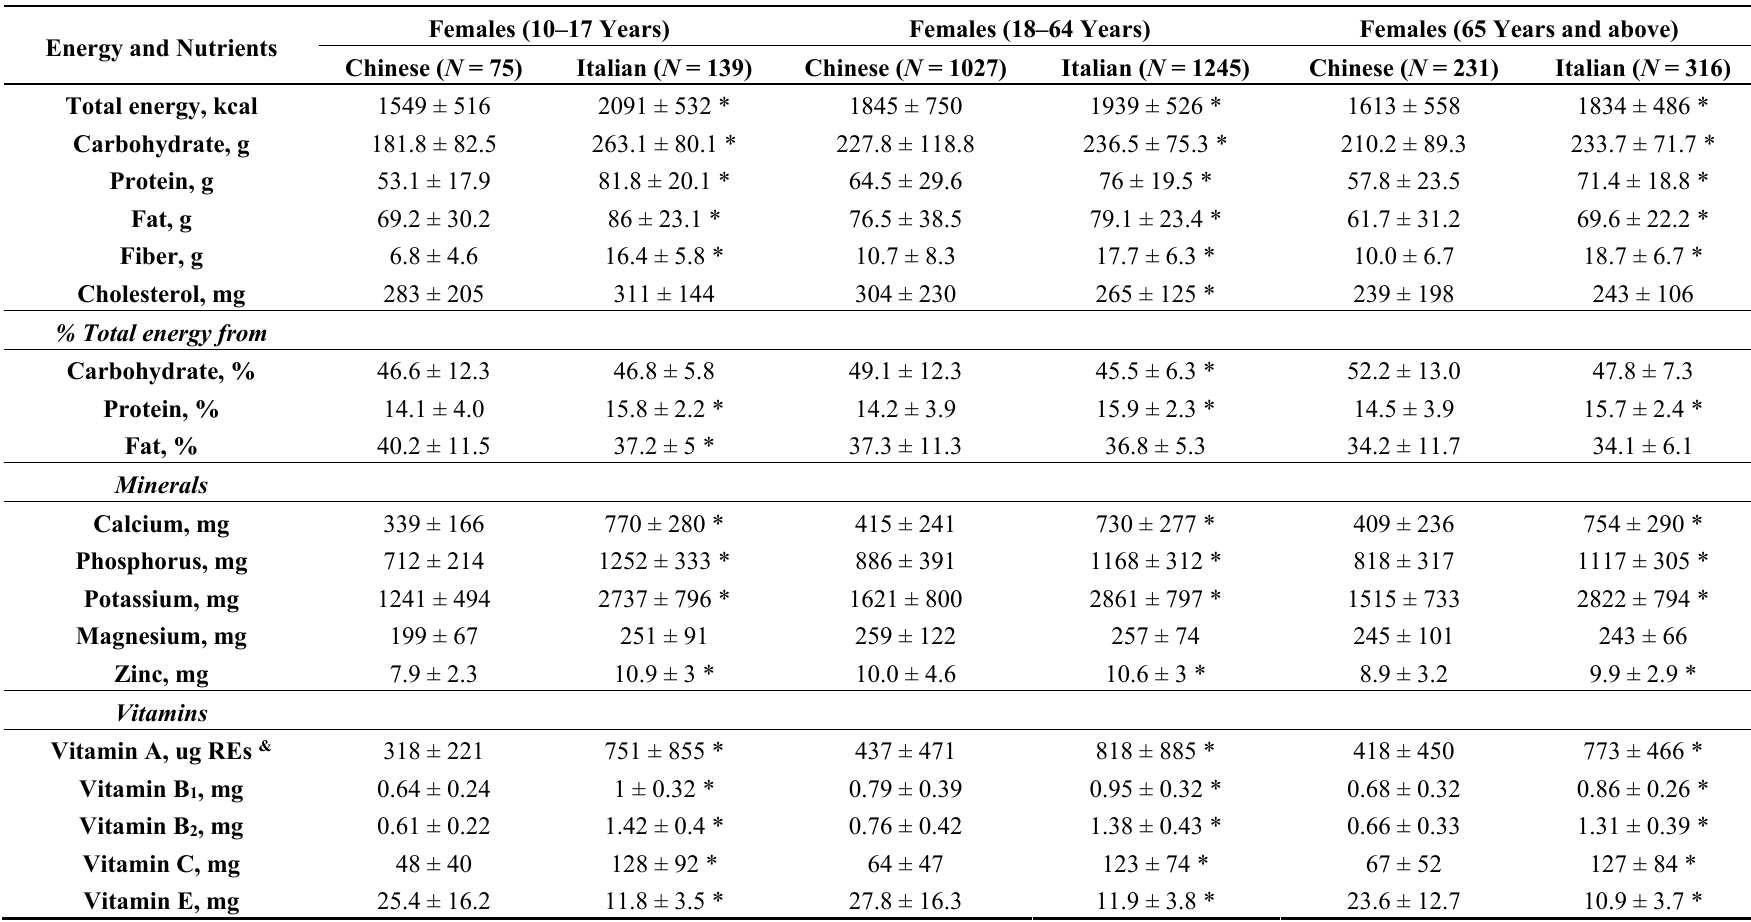
Table 6. Comparison of intake of energy and nutrients # by age in females in the Chinese and Italian groups. Energy and